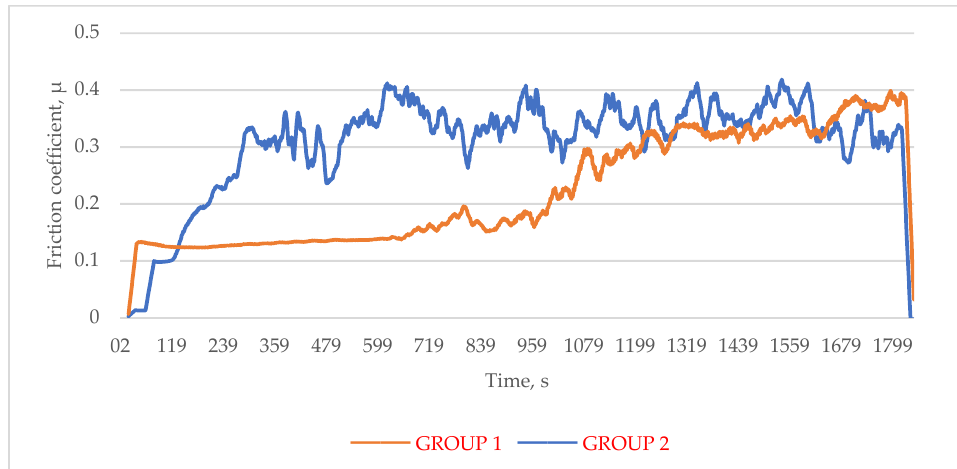
Figure 7. Change of the friction coefficient as a function of time.